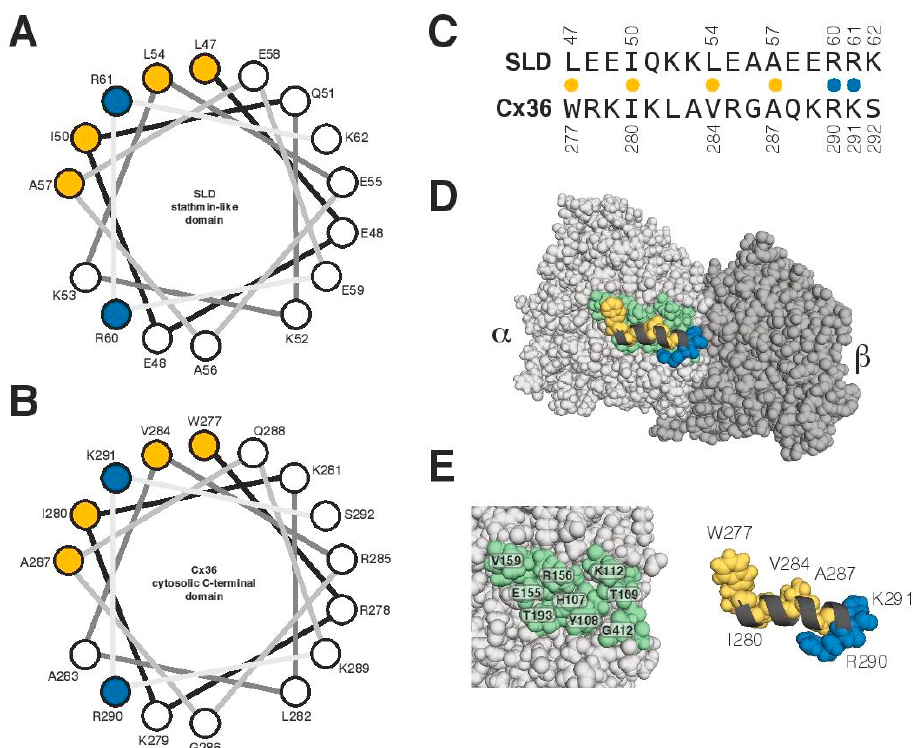
Figure 8. Structural modeling of the CT: A model of the interaction between Cx36 and tubulin. When sequence and secondary structure similarity are considered together, the crystal structure of an engineered stathmin-like domain (SLD) and an alpha / beta tubulin protofilament (PDB: 1Z2B) emerges as a possible template to consider an analogous Cx36 interaction. ( A , B ) Helical wheel representations of the relevant regions of the SLD (47–62) and Cx36 (277–292) with key amino acids colored at the interface according to either hydrophobicity (orange) or charge (blue). ( C ) A sequence comparison following the same scheme as the helical wheel. ( D , E ) Three views of a Cx36 / tubulin model highlighting the potential contacts made between Cx36 (black ribbon) and alpha tubulin (light grey and green). Models were created in PyMOL v1.86.